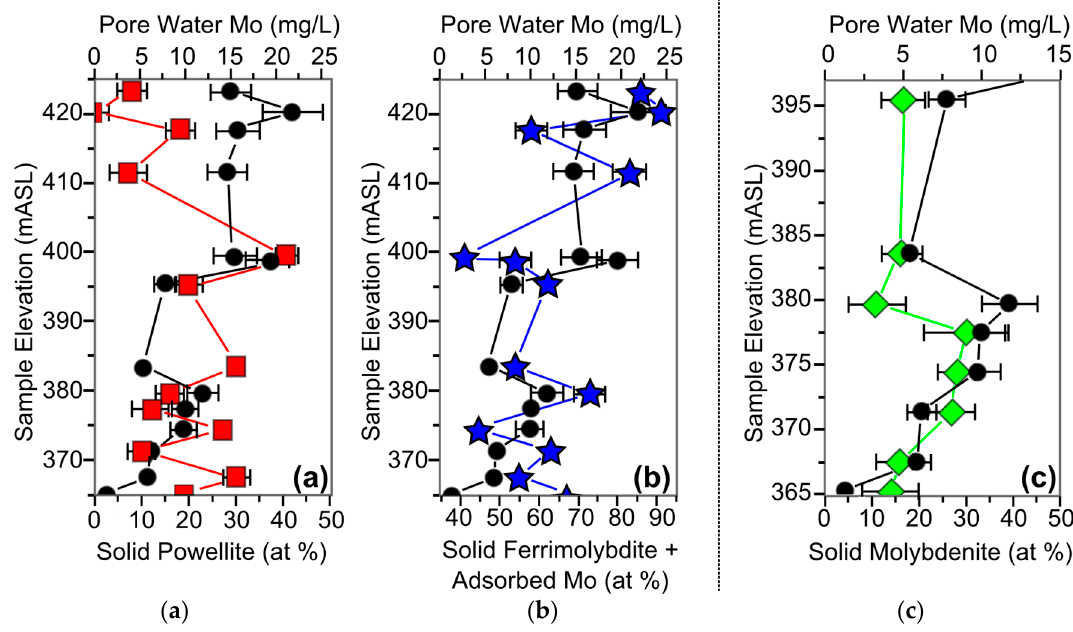
Figure 2. Aqueous Mo pore water concentrations (black lines) compared to relative amounts of solid ( a ) powellite (red line), ( b ) ferrimolybdite and molybdate adsorbed on ferrihydrite (blue line) and ( c ) molybdenite (green line). Errors in the Mo pore water concentrations are c. 15% for concentrations >1 mg/L. Error bars are only shown where they exceed the size of the symbol. A dashed line separates plot ( c ) because of the different sample elevation for this plot relative to plots ( a , b ). Data are taken from borehole TMF 13-01 from the uranium mining operation JEB Tailings Management Facility, Saskatchewan, Canada. Reprinted (adapted) with permission from Blanchard et al. [56]. Copyright (2015) American Chemical Society.